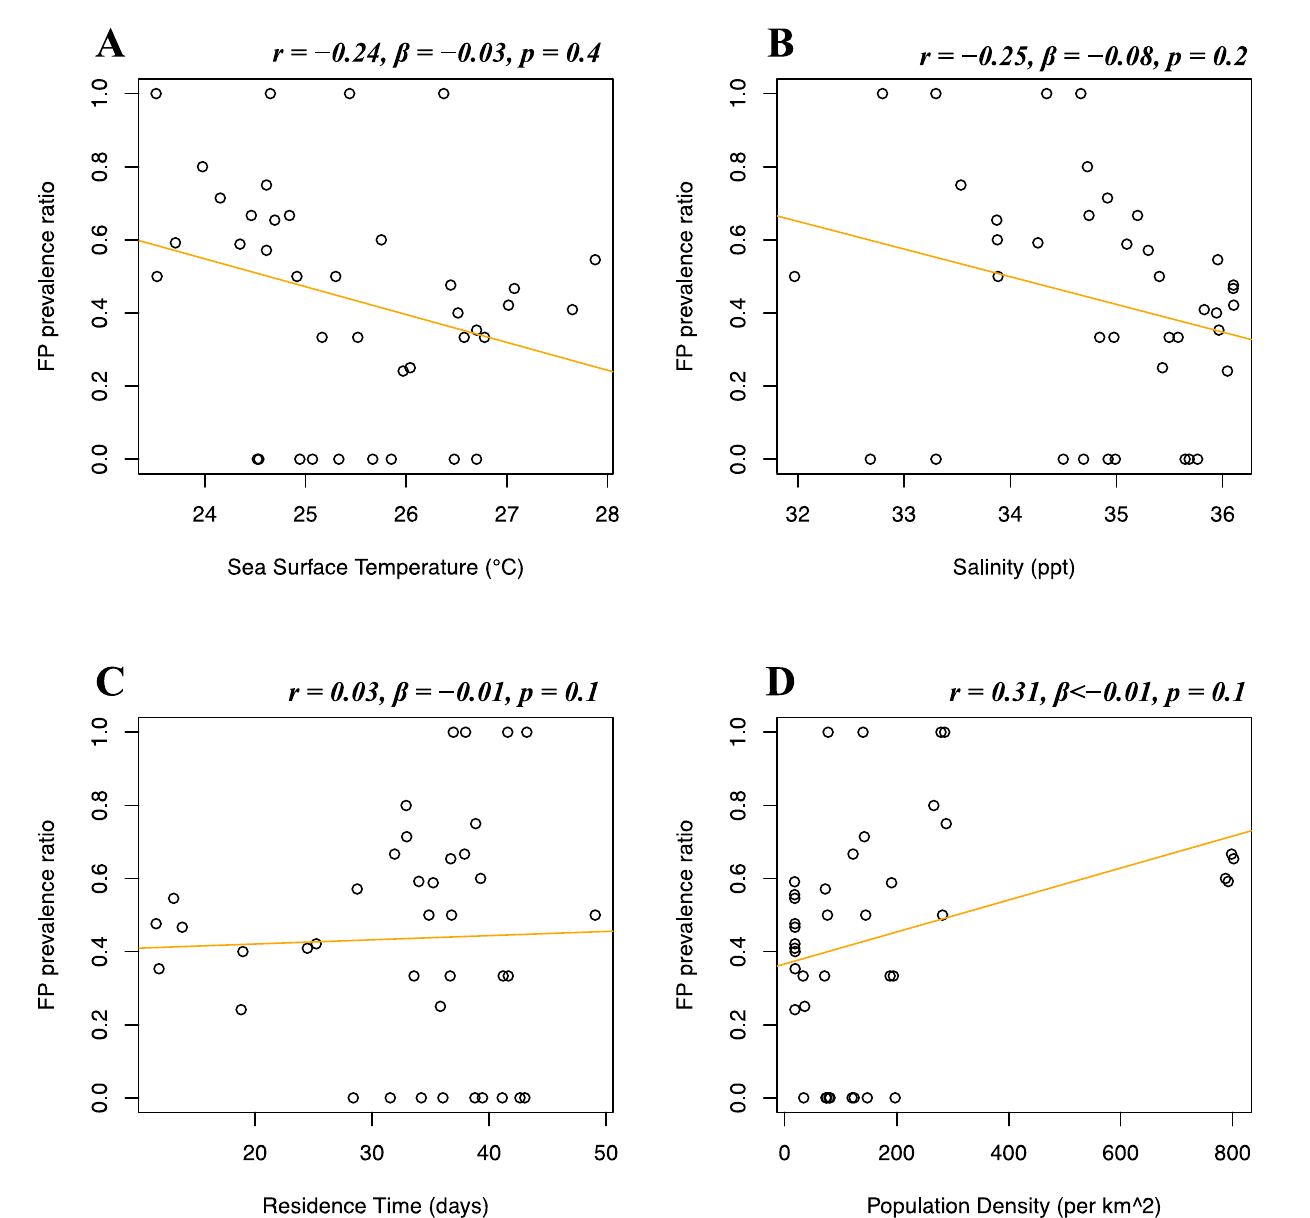
Figure 6. Florida Gulf coast stranded dataset FP prevalence and environmental and demographic variables. Scatterplots with fitted regression lines representing the logistic regression output from the response variables versus predictor variables in the Florida Gulf coast stranded dataset. The subplots show FP prevalence ratio on the y -axis versus sea surface temperature ( A ), salinity ( B ), residence time ( C ), and human population density ( D ) on the x -axis. Pearson correlation ( r ), beta-coefficient ( β ), and p -value ( p ) are reported for each predictor variable on the top right of the respective plot.